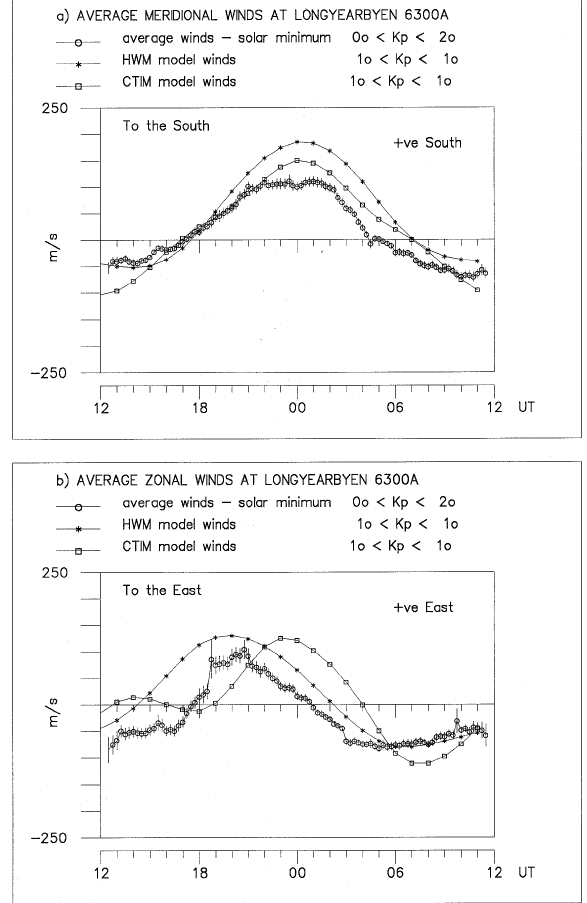
Fig. 10. Comparison of average meridional neutral winds for ge- omagnetically quiet conditions (0 < Kp < 2) at solar minimum (mean F 10 . 7 = 100) measured with a FPI at Longyearbyen with theoretical CTIM model winds and empirical HWM model winds simulated by using Kp = 1 and F 10 . 7 = 73. There is a severe overestimation of the wind magnitudes by the model, which prob- ably arises from an overestimation of momentum transfer through ignoring meso-scale